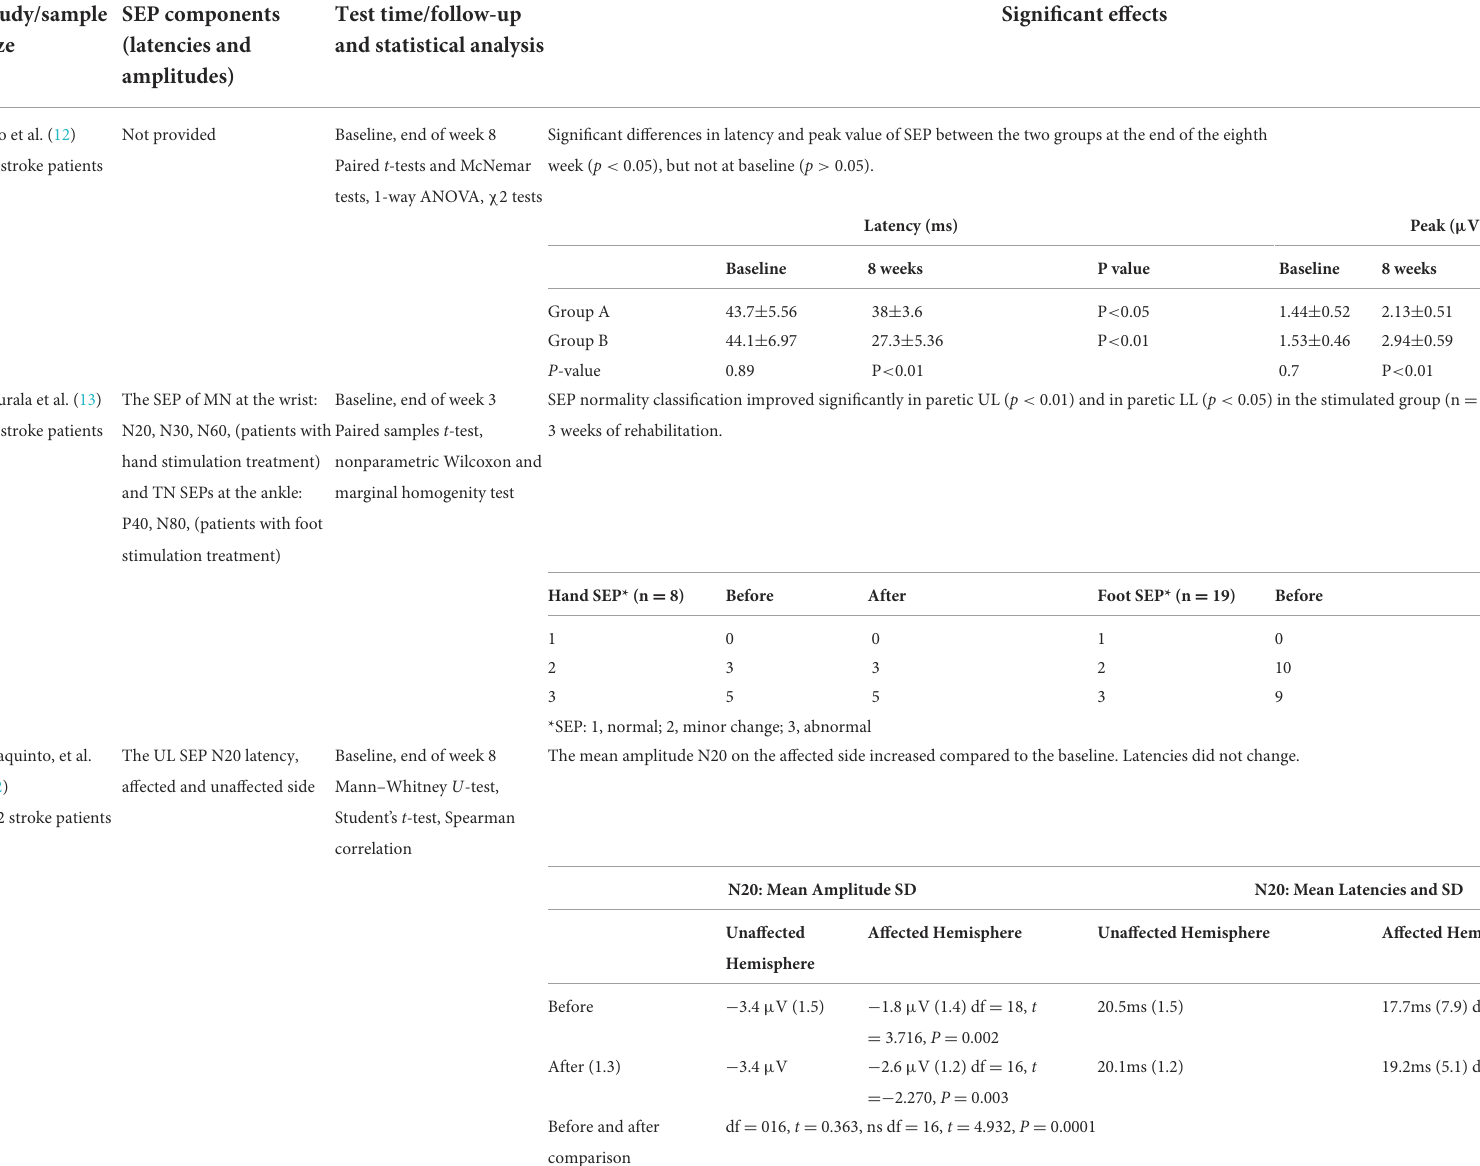
TABLE 4 Latencies and Amplitudes of SEP Components—Pre–Posttest –Studies made on stroke